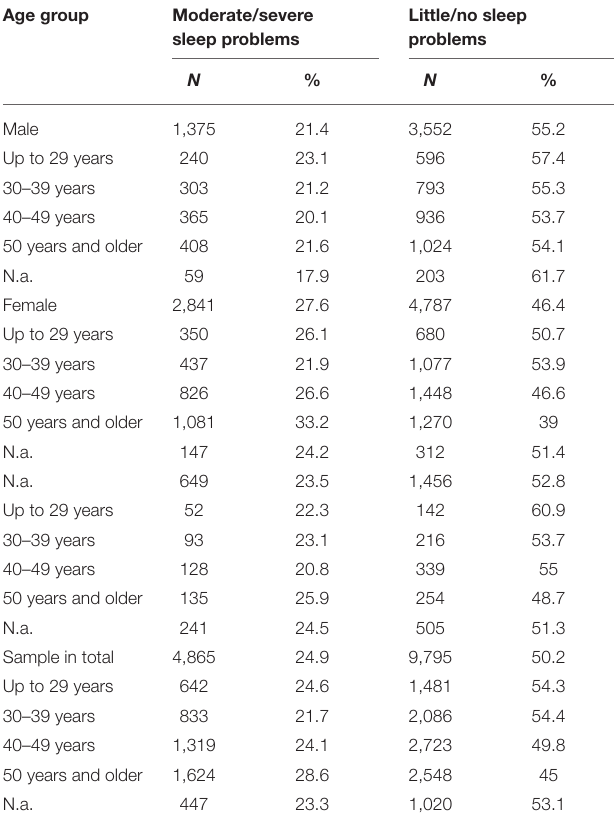
TABLE 1 | A table to show the frequency of respondents to the sleep question, broken down by age and gender. Age